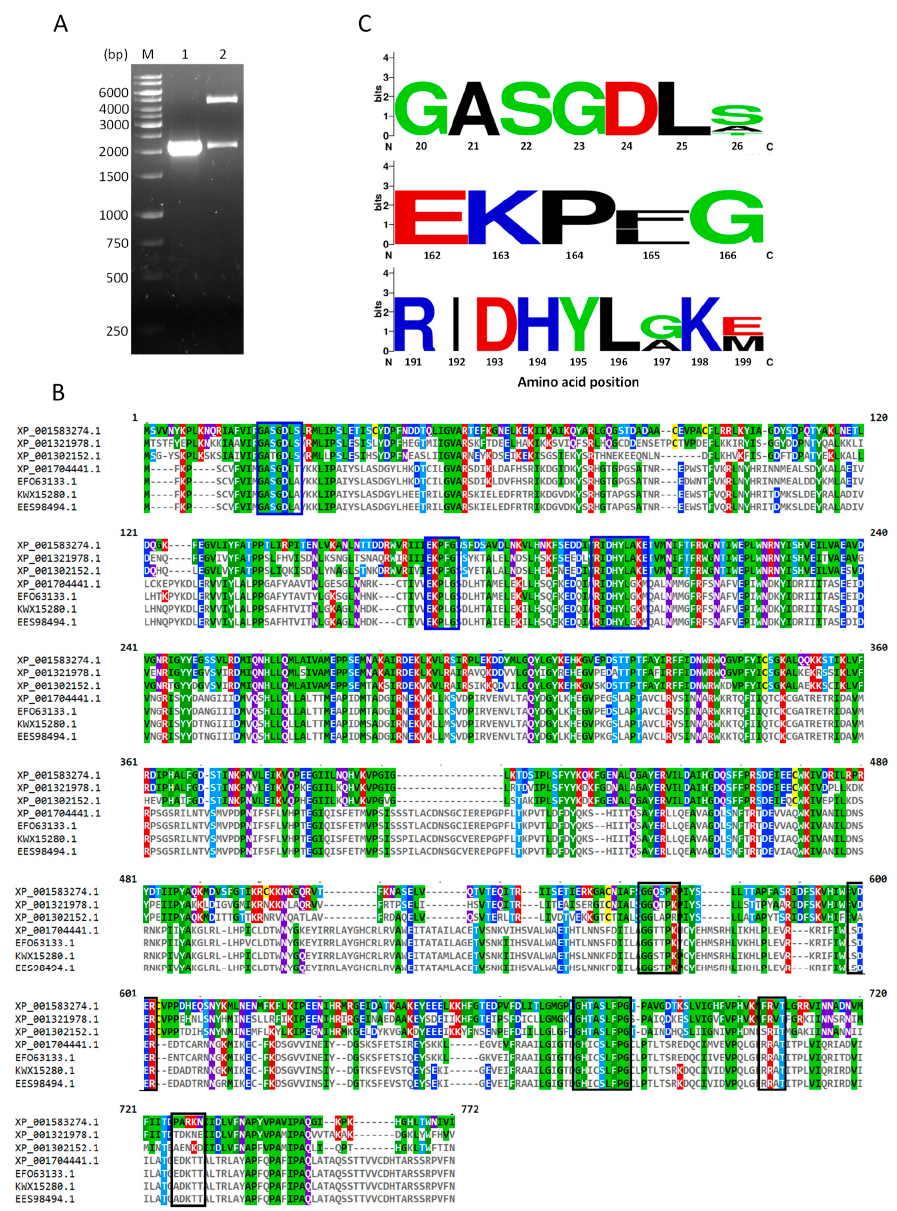
Figure 1. Cloning the glucose-6-phosphate dehydrogenase-phosphogluconolactonase ( g6pd::6pgl ) gene from T. vaginalis and an analysis of the protein sequence. ( A ) Agarose gel (1%) showing the amplification of the TvG6PD::6PGL gene by PCR (lane 1) and verifying the cloning of the gene in the expression vector (pET3a-HisTEV) by digestion with the restriction enzyme Nde I- Bam HI (lane 2). M: The GeneRuler 1 kb DNA marker (Thermo Scientific, Waltham, MA, USA). ( B ) Multiple sequence alignment of the amino acids of G6PD::6PGL between T. vaginalis and G. lamblia . The sequences of G6PDs used for alignment were XP_001583274.1 ( Trichomonas vaginalis G3), XP_001321978.1 ( T. vaginalis G3), XP_001302152.1 ( T. vaginalis G3), XP_001704441.1 ( Giardia lamblia ATCC 50803), KWX15280.1 ( G. intestinalis assemblage B, EFO63133.1 ( G. lamblia P15), and EES98494.1 ( G. intestinalis ATCC 50581). The fragments conserved for G6PD are indicated in blue boxes and those for the 6PGL are shown in black boxes. The percentage of amino acid identity found between the T. vaginalis (TvG6pd::6PGL) sequence with respect to the G . lamblia sequences was 30%, even though both proteins are fused. Multiple sequence alignment was done with ClustalW and visualized with MView. ( C ) Comparison of conserved sequences between Giardia , Trichomonas , and Homo sapiens G6PD made with the weblogo online